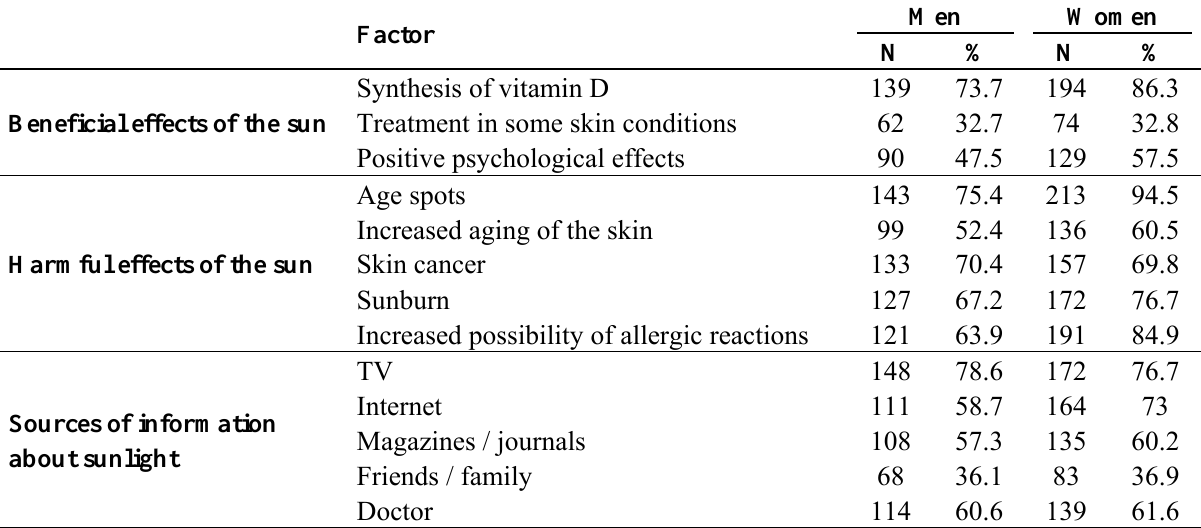
Table 3. Students’ levels of knowledge about